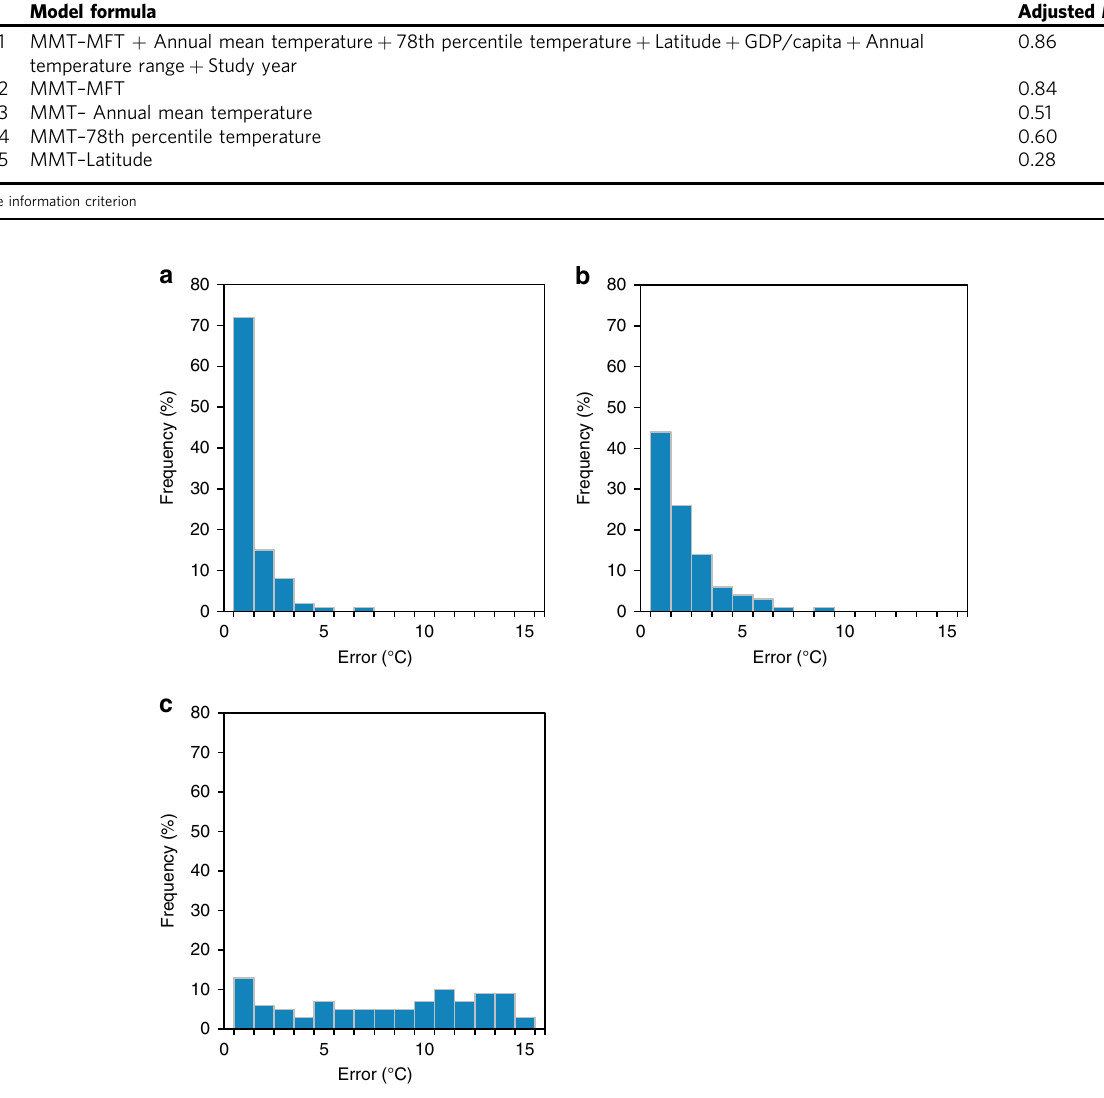
Fig. 2 Error histograms for three temperature indicators as MMT. a – c Respectively show the error distributions of MFT as MMT, the 78 th percentile temperature as MMT, and annual mean temperature as MMT. By comparing the errors of using three temperature indicators to represent MMT, MFT is proved to be a better indicator. a Using MFT as the surrogate for MMT, the locations with an error of less than 1 °C account for a proportion of 71%, which is much higher than using the 78 th percentile temperature (44%, b ) and the annual mean temperature (13%, c ) to represent